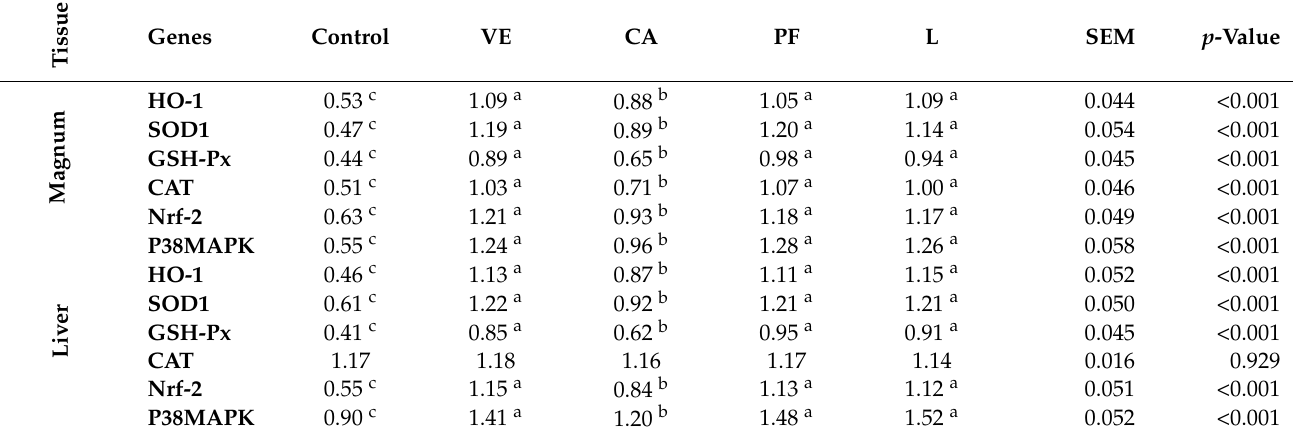
Table 7. The effect of different antioxidants on the relative mRNA gene expression of laying